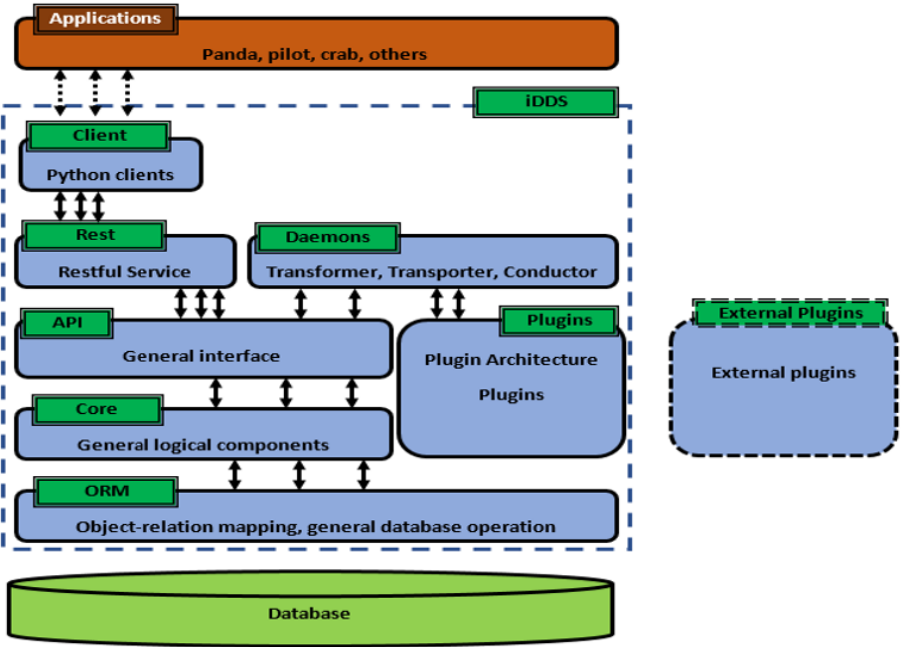
Fig. 3. A schematic view of the Architecture of Intelligent Data Delivery